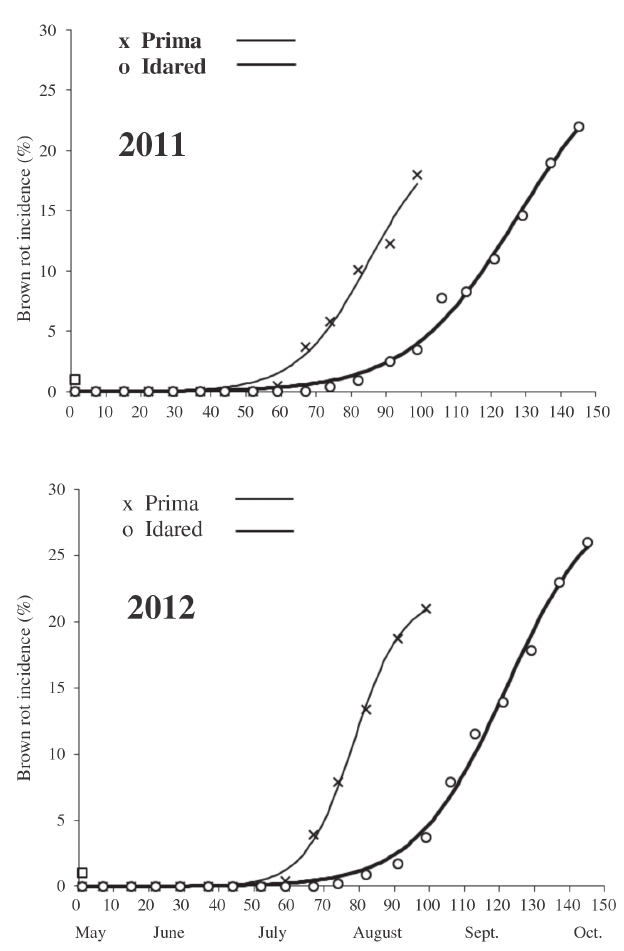
Figure 1 Disease progress curves of brown rot incidence caused by M. fructigena assessed on three apple cultivars (Prima, x and Idared, o) in an organic apple orchard (2011-2012, Mándok, Hungary). Points represent mean values and smooth lines are the fitted curves of logistic regression. Descriptive disease variates Values of descriptive disease